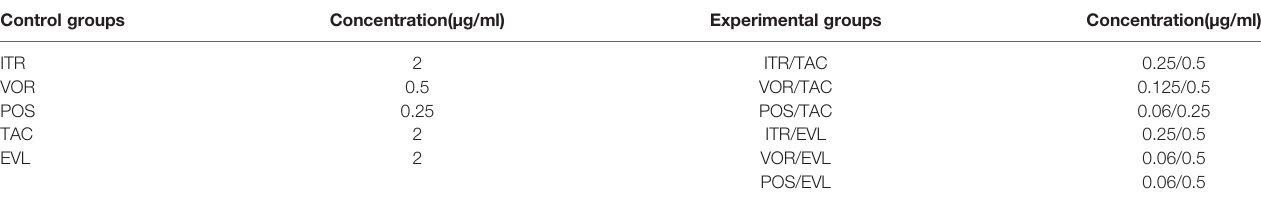
TABLE 2 | ROS activity and apoptosis experiments with different drug